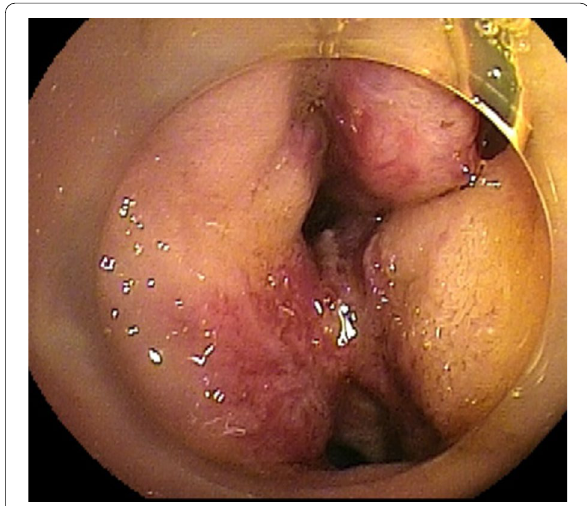
Fig. 2 Preoperative findings of double-balloon enteroscopy. Capillary and venous dilatation of the mucosa near the hepaticojejunostomy site and varicose vein elevation were detected